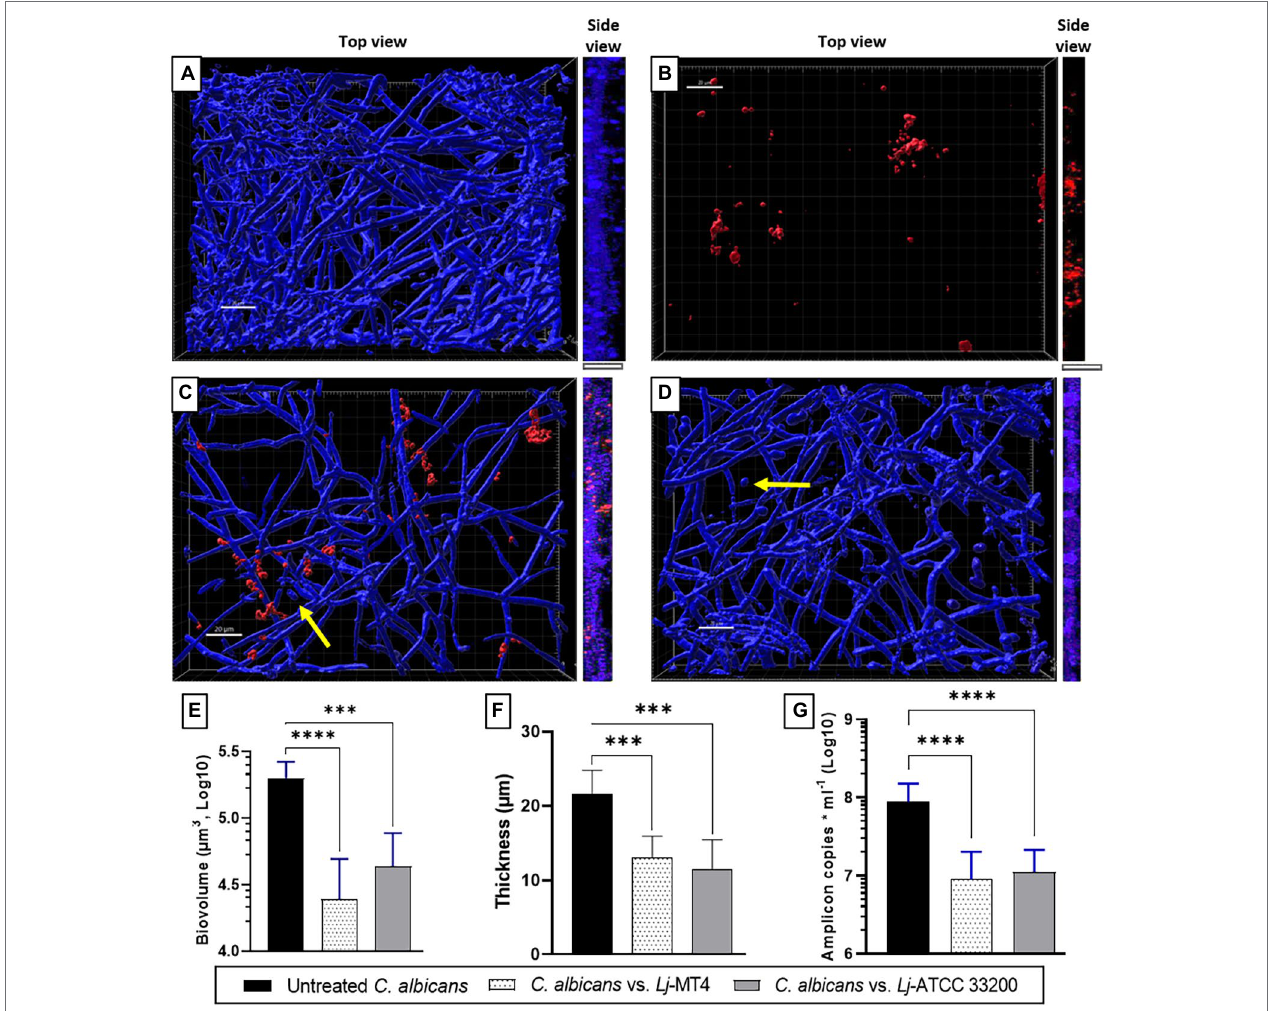
FIGURE 7 | Lactobacillus johnsonii reduces the ability of C. albicans to form biofilms. (A) Single C. albicans biofilms uniformly cover the surface; (B) Single L. johnsonii biofilms consist of scattered clusters of cells; C. albicans biofilm formation is reduced by L. johnsonii (C) MT4 and (D) ATCC 33200. Fungal biofilm (E) biovolumes, (F) thickness, and (G) biomass are significantly reduced in the presence of lactobacilli. Yellow arrows indicate the presence of yeast cells. White bar = 20 μ . One-Way ANOVA, Dunnett posttest. *** p ≤ 0.005, **** p ≤